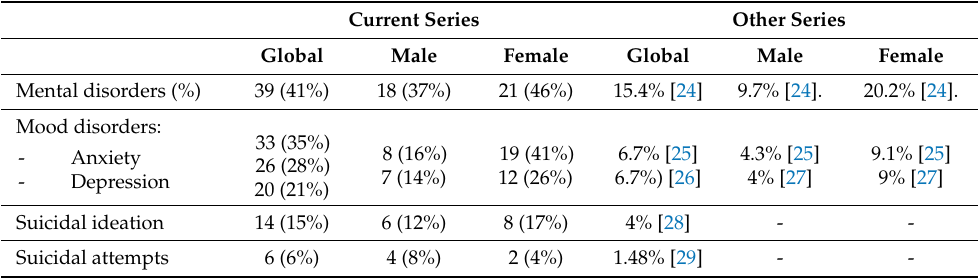
Table 5. Prevalence of mental disorders in our series compared with general population